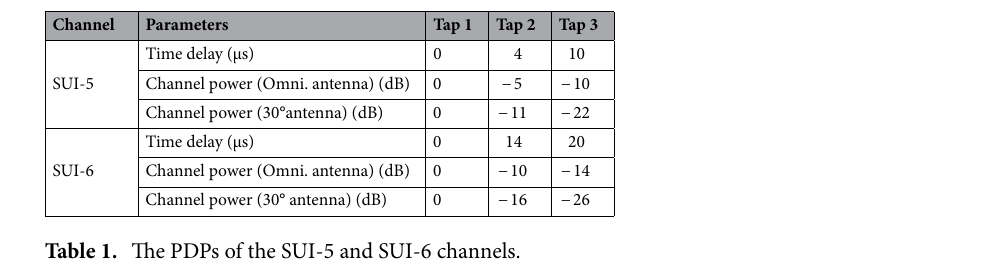
Table 1. The PDPs of the SUI-5 and SUI-6